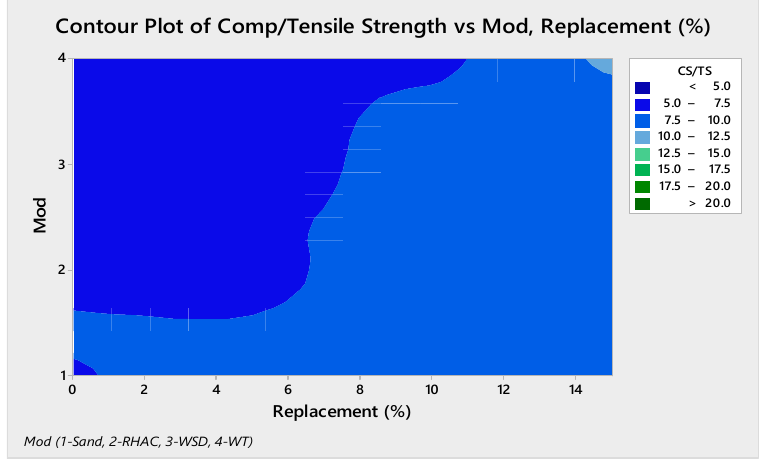
RHAC. The contour plot among the tensile/flexural strength ratio is shown in Figure 8 below.